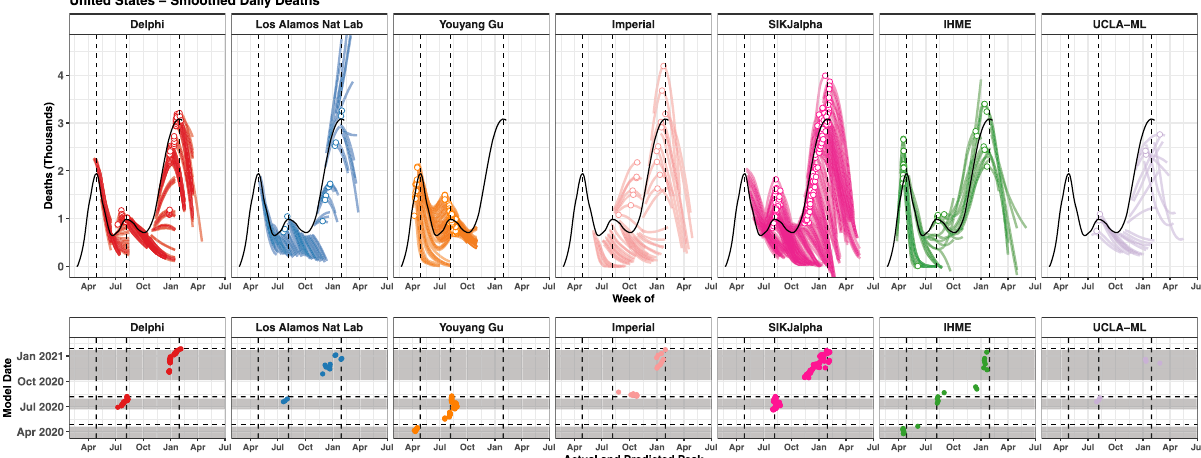
Fig. 6 Observed vs predicted to peak in daily deaths — example for the United States. Observed daily deaths, smoothed using a loess smoother, are shown as a black line (top). The observed peak in daily deaths is shown with a vertical dashed line (top and bottom). All versions of each model are shown (top), and each model version that was released at least one week prior to the observed peaks has its estimated peak shown with a point (top and bottom). Estimated peaks are shown in the bottom panel (circles) with respect to their predicted peak date ( X axis) and model date ( Y axis). The grey bands represent the windows prior to each peak within which forecasted peaks were considered, which extend from when the time series began to increase, to 1 week prior to each peak. Values are shown for the United States, and similar graphs for all other locations are available in the Supplementary. Delphi DELPHI-MIT (red), Los Alamos Nat Lab Los Alamos National Laboratory (blue), Youyang Gu (orange), Imperial Imperial College London (peach), SIKjalpha USC SIKJ-alpha (pink), IHME Institute for Health Metrics and Evaluation (green), UCLA-ML UCLA Statistical Machine Learning Lab (purple).